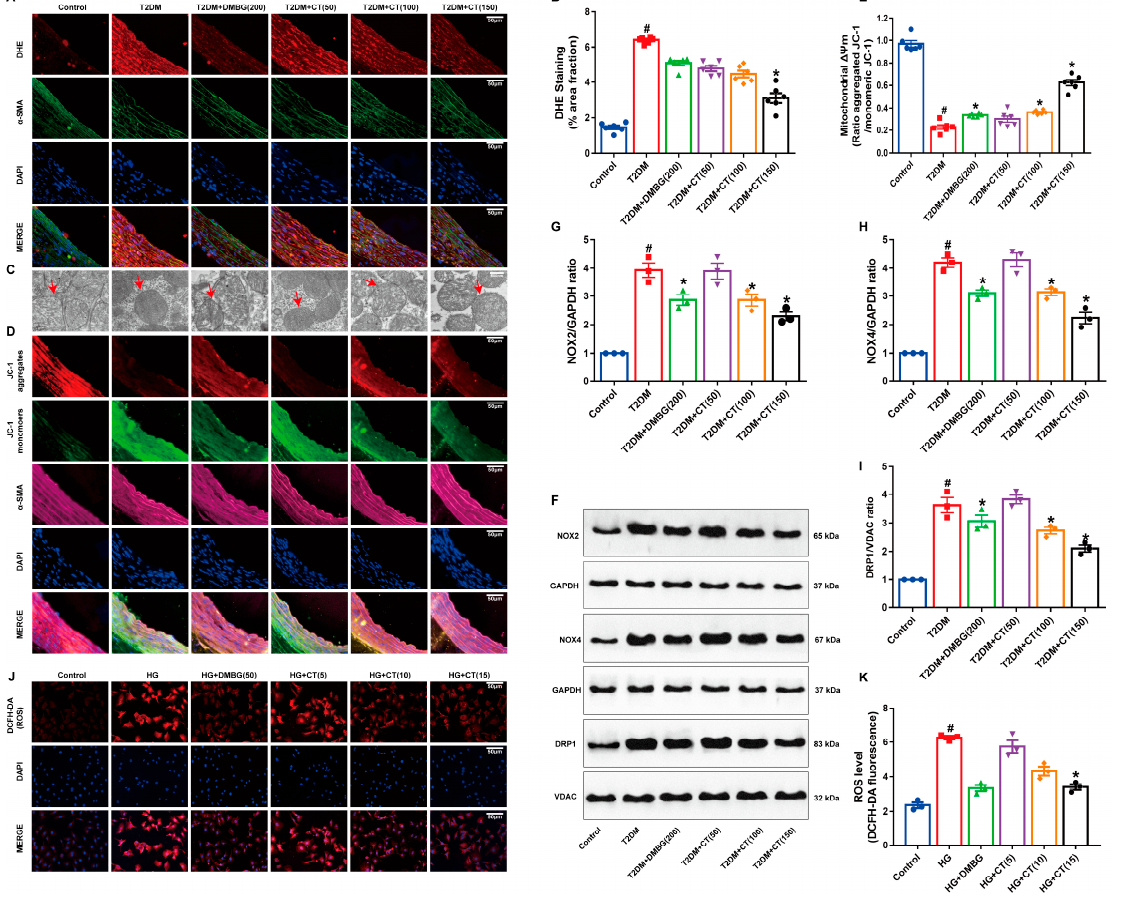
Figure 3. CT reduced oxidative stress-induced mitochondrial damage in carotid arteries of T2DM rats. ( A ) Detection of superoxide anion level in carotid arteries (DHE, red ; α -SMA, green ). ( B ) confocal microscopic images. ( C ) Ultrastructural analysis of mitochondria under electron